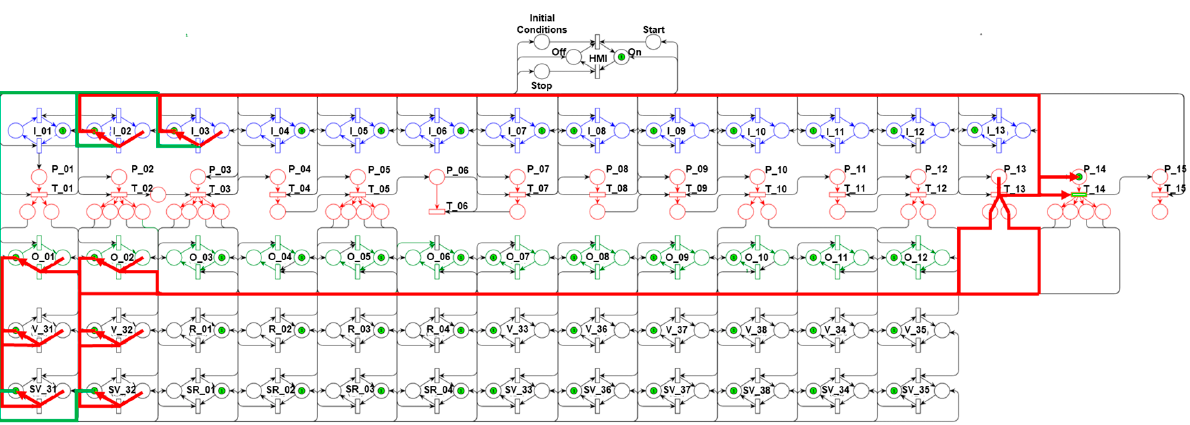
Figure 36. Algorithm’s 15th step—Close valves.